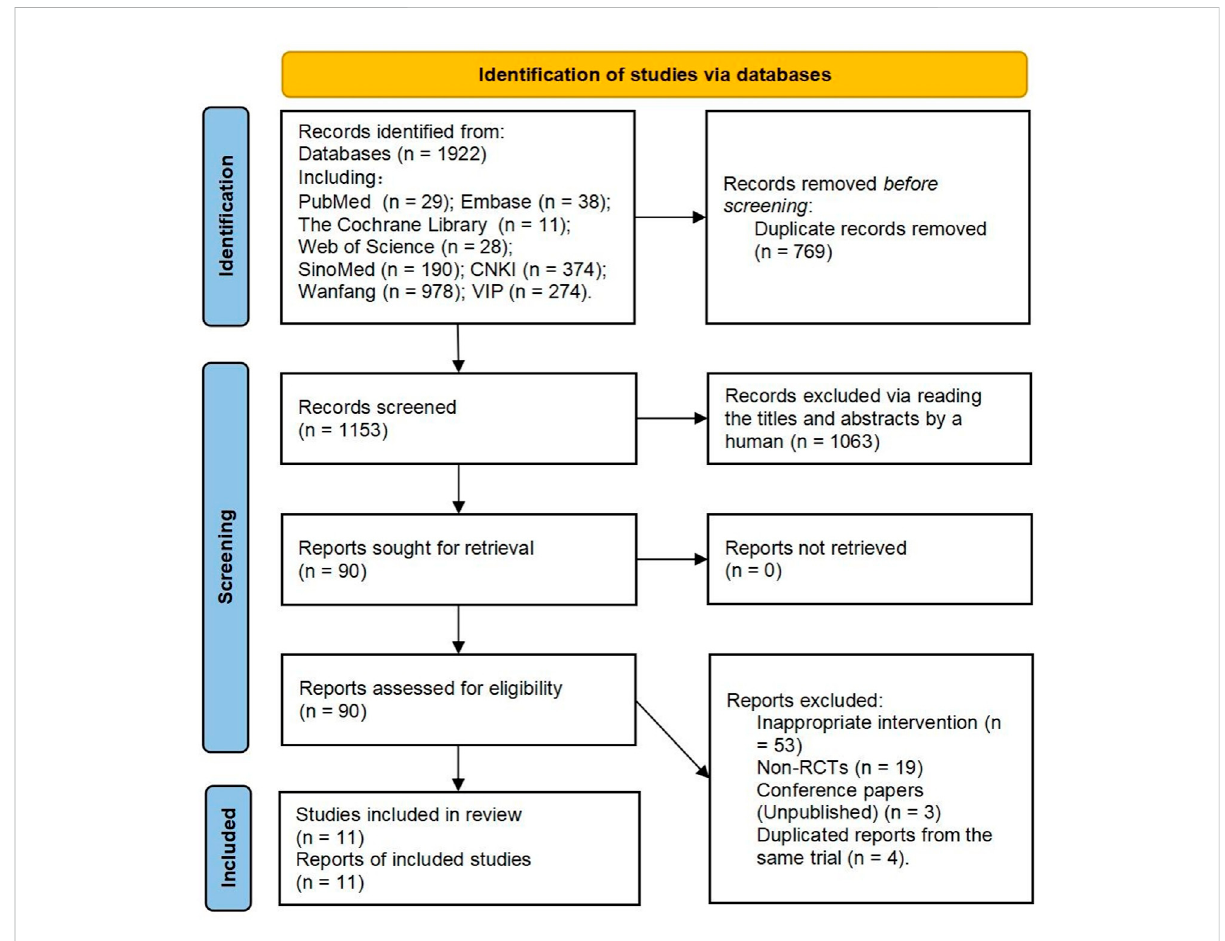
FIGURE 2 The fl ow diagram of study retrieval and